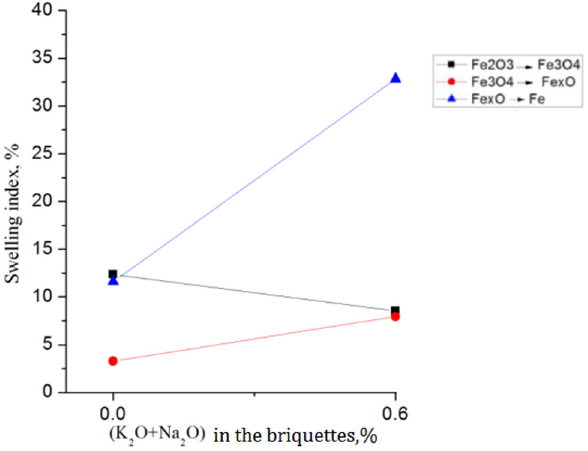
Figure 2: Reduction swelling rate of roasted